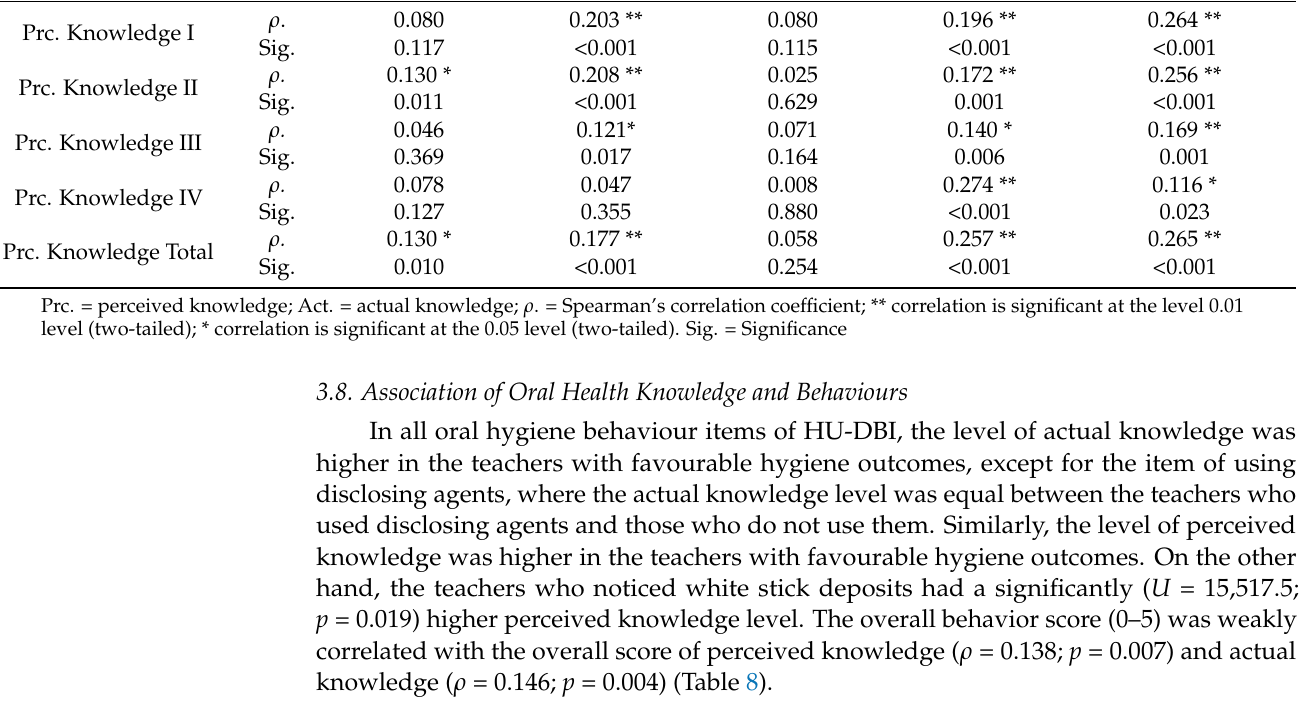
Table 7. Correlation of perceived oral health knowledge and actual knowledge of elementary schoolteachers. Variable